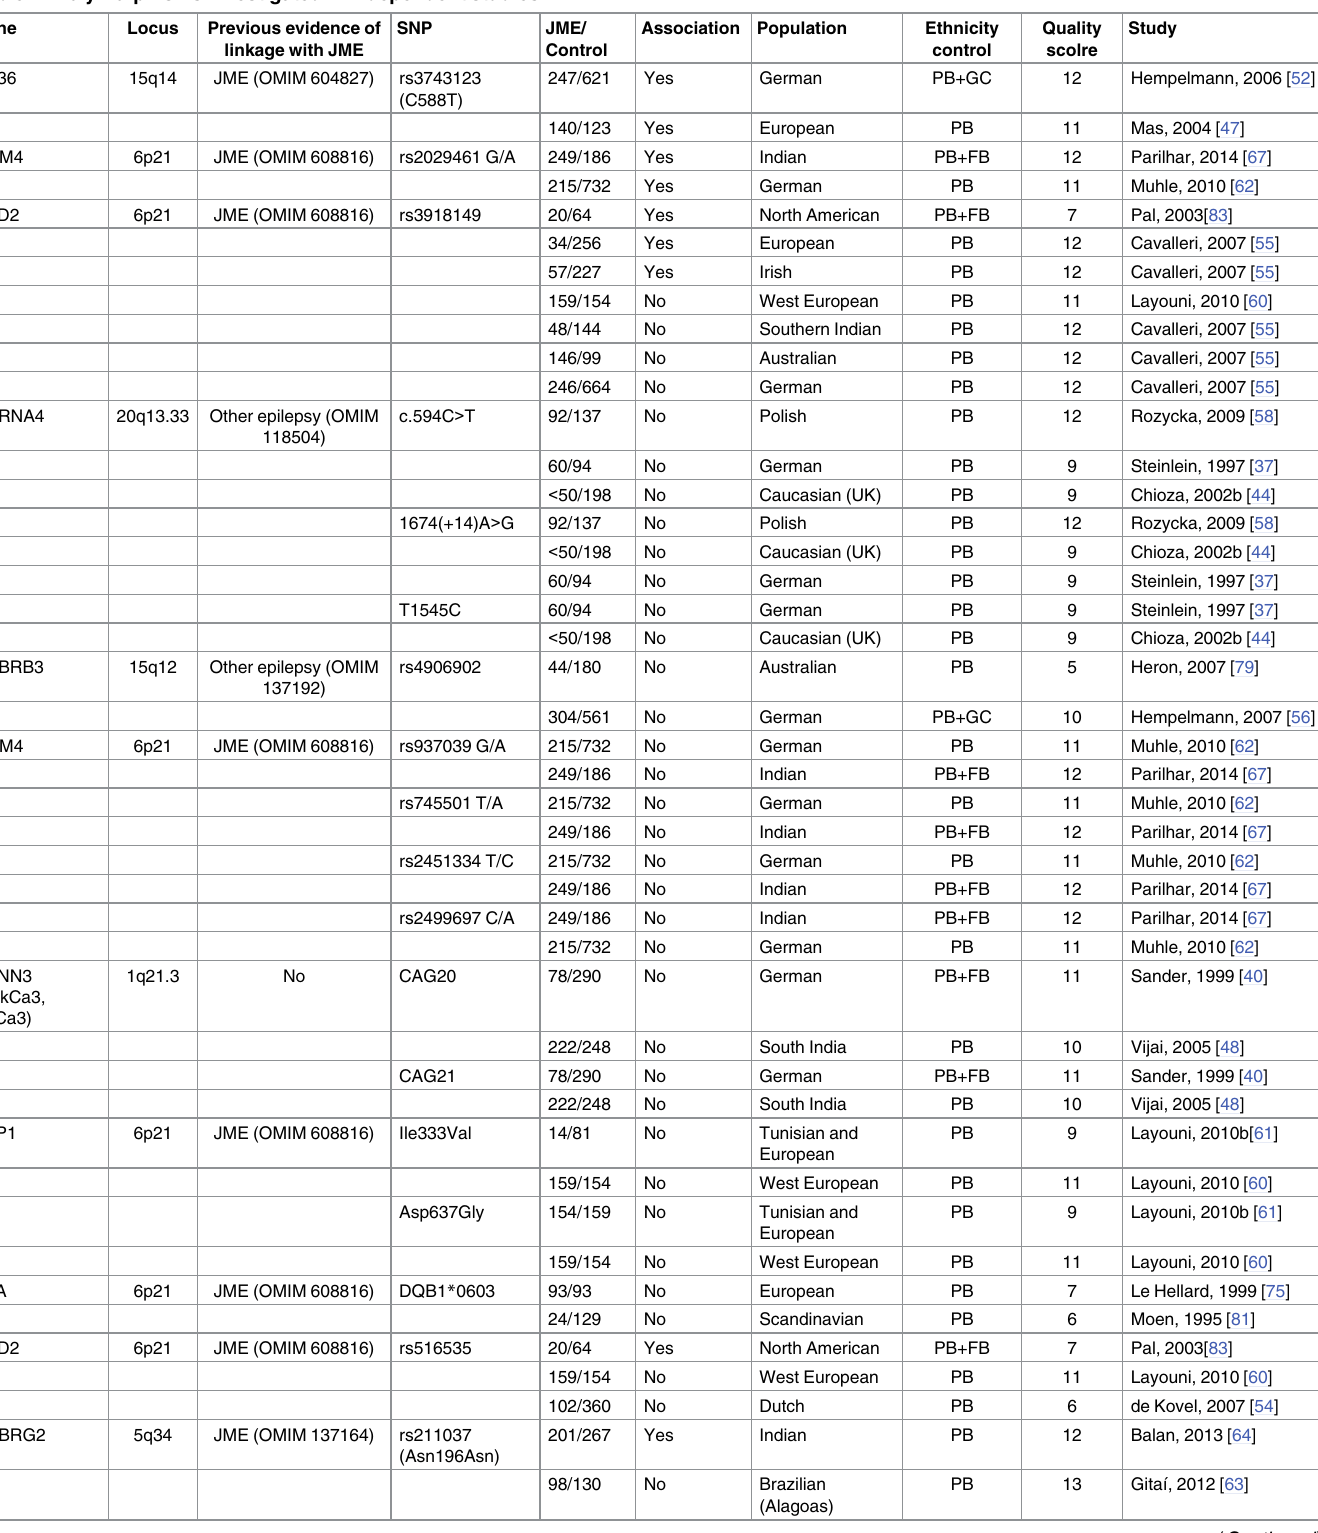
Table 1. Polymorphisms investigated in independent studies. Gene